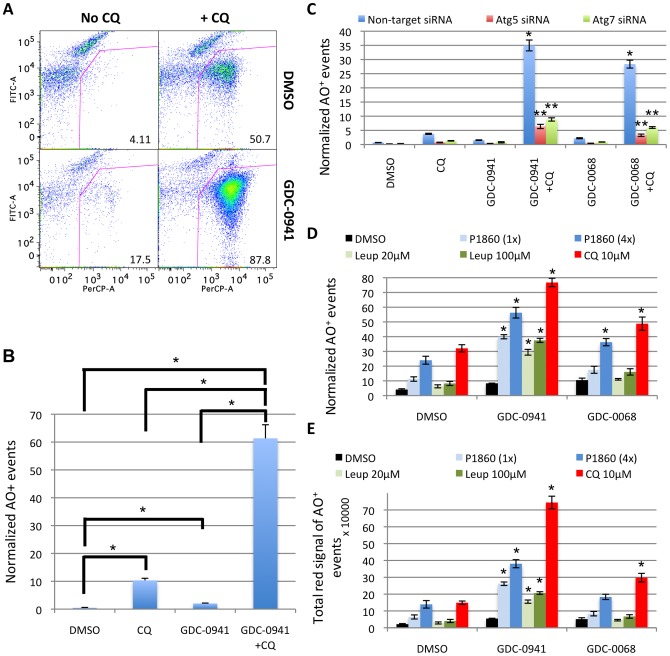
Pharmacologically induced acidic vacuoles can be individually detected by OFACS from sonicated cells stained with AO.
(A) PC3 cells treated with 1 µM GDC-0941 and 10 µM CQ for 2 days analyzed by OFACS after staining with AO. FITC (green) vs. PerCP (red) channels of the organelle population are plotted. Percentage of the gated AO+ population is shown for each plot. (B) Quantification of the number of AO+ events as gated in (A) normalized to the number of cells used for sonication with each treatment. *, P<0.05. (C) Quantitative analysis by OFACS showing the normalized number of AO+ events under indicated treatments. PC3 cells transfected with Atg5 or Atg7 siRNA for 2 days were treated with 1 µM GDC-0941 or 5 µM GDC-0068 +/− 10 µM CQ for an additional day. *, P<0.05 vs. DMSO, CQ or GDC-0941/GDC-0068 alone with non-target siRNA; **, P<0.05 vs. non-target siRNA in the same treatment group. (D,E) Quantification of AO+ events obtained by OFACS analysis of PC3 cells treated with GDC-0941 or GDC-0068 +/− CQ or protease inhibitors for 2 days, showing the normalized number of AO+ events (D) and the total “red” signal intensity of AO+ events (E), derived by multiplying the number of AO+ organelles by the mean value of the “red” AO signal. *, P<0.05 both vs. DMSO group treated with the same lysosomal inhibitor and vs. GDC-0941 or GDC-0068 alone. Error bars represent SEM (n = 3). P values are determined by Student's t-test. Representative data from one of three independent experiments are shown. All quantifications are normalized to the number of cells used for the sonication under each condition.